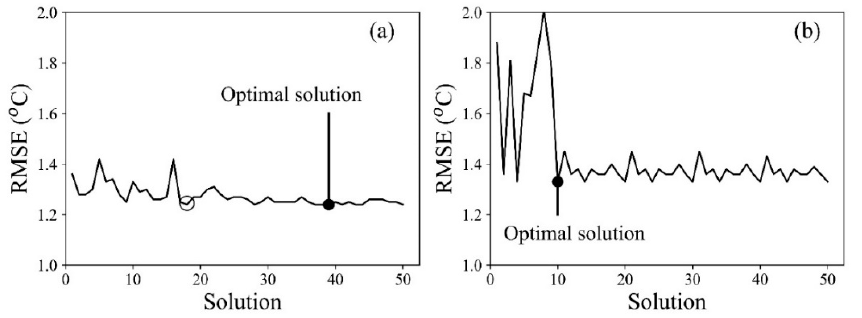
Figure 5. ( a ) IGHS solutions and ( b ) PSO solutions generated through 50 iterations for calibration of CE-QUAL-W2 model. Black open and filled dots represent the local and global optimum solutions.